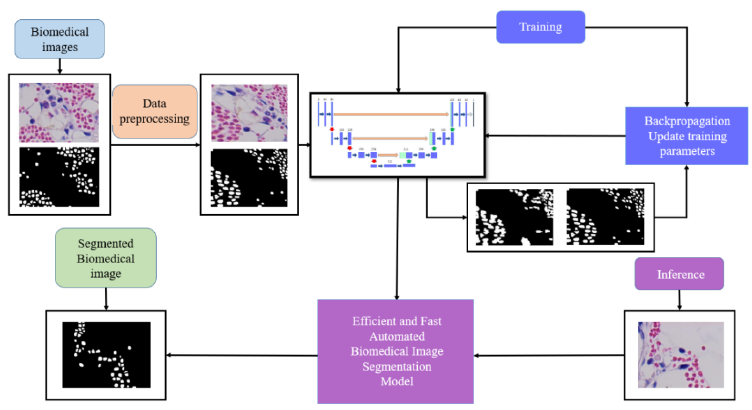
Figure 1. The proposed methodology.